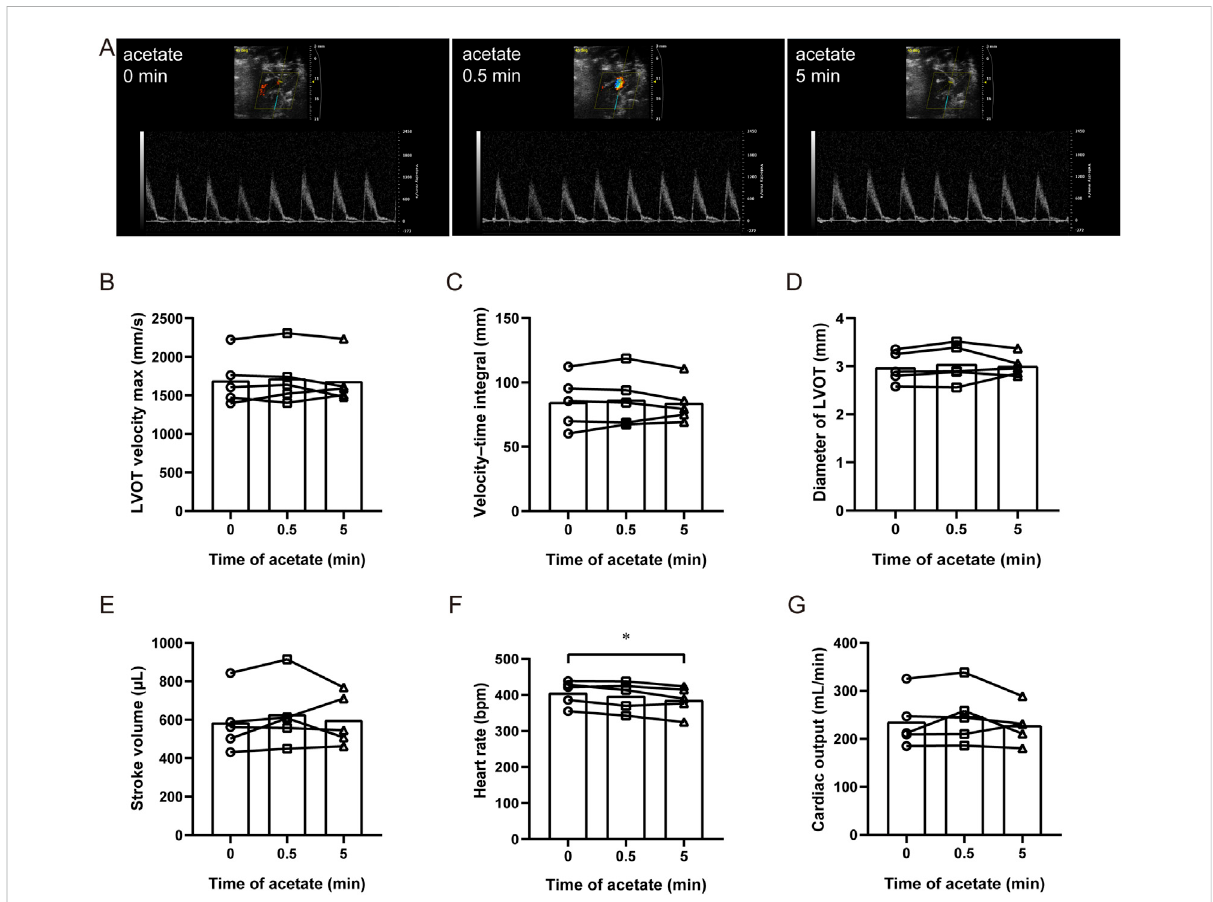
FIGURE 1 Acetatehasnoeffectoncardiacoutputinrats.Representativeoriginalimageofultrasoniccardiograminanesthetizedratsbyiso fl urane (A) .The maximalblood fl owvelocityattheleftventricularout fl owtract (B) ,thevelocity – timeintegral (C) ,thediameteroftheleftventricularout fl owtract (D) , cardiac stroke volume (E) , heart rate (F) , and cardiac output (G) in anesthetized rats. N = 5. N: the number of rats. * p <